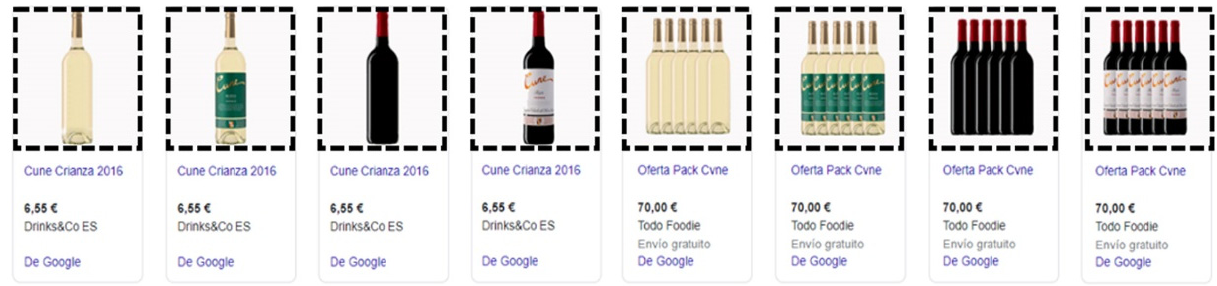
Figure A1. Selection of areas of interest.